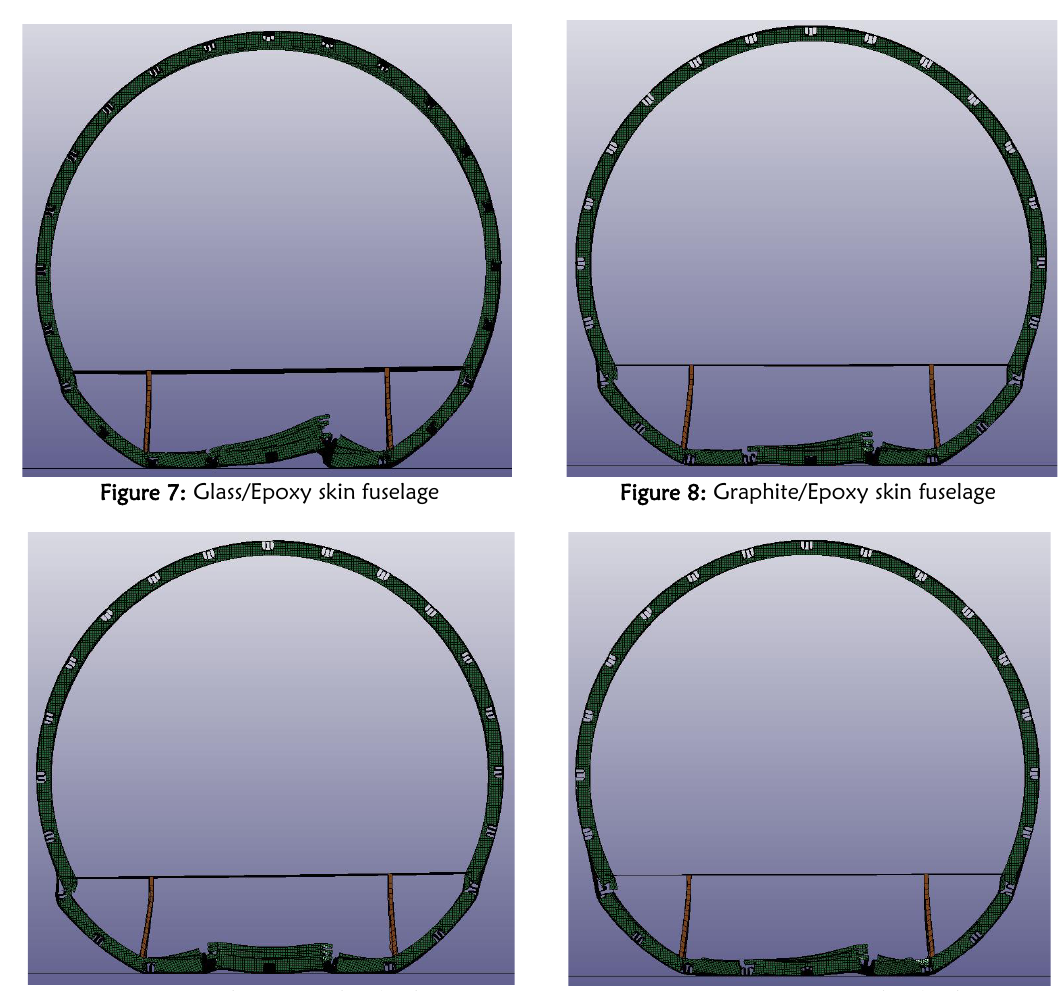
Figure 9: Kevlar/Epoxy skin fuselage Figure 10: Boron/Epoxy skin fuselage